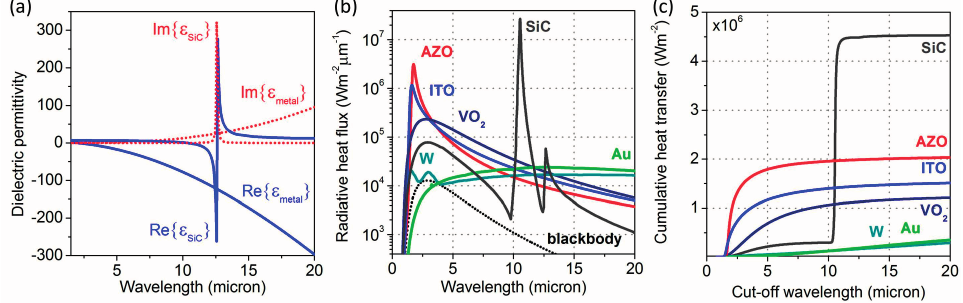
Figure 2. SPP- and SPhP-mediated heat flux spectra. ( a ) Complex dielectric permittivities ε of the polar dielectric (SiC) and a Drude-like metal with m1.1 μλ = , THz30 =γ , 3 = ∞ p (blue solid lines: real parts, red dotted lines: imaginary parts). ( b ) Heat flux spectra as a function of wavelength between semi-infinite bulk emitters and absorbers supporting surface polaritons. The emitter and absorber are separated by a 20 nm gap. The hot and cold side temperatures are 1000 K and 360 K, respectively. The 360 K value was chosen to ensure that VO 2 is in its metallic form [62]. The blackbody heat flux is shown as the dotted line for comparison. Au, SiC and W permittivity values are taken from [63], the ITO and AZO ones from [64], and VO 2 values from [62]. ( c ) Cumulative heat flux per unit area in λ between the same materials as in the spectral range below a cut-off wavelength c